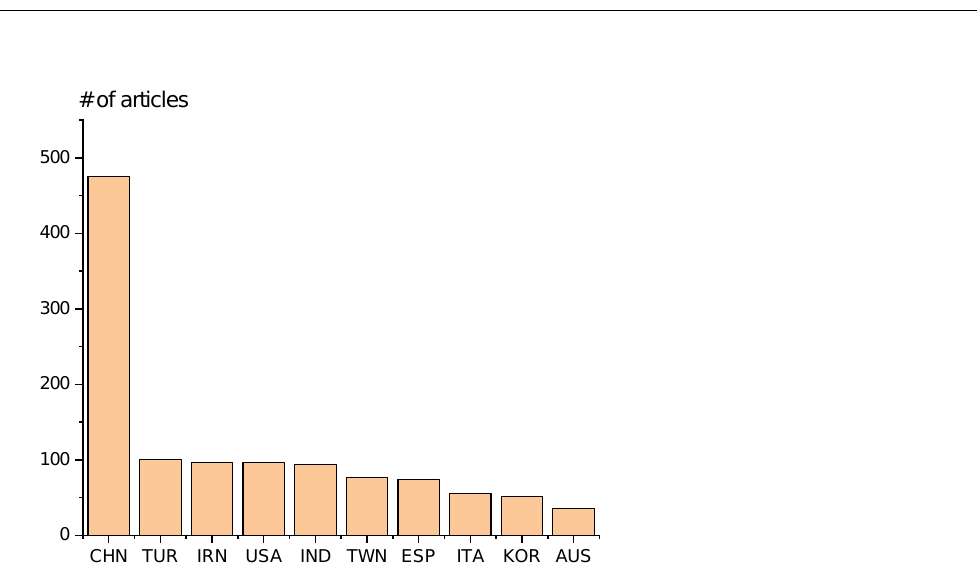
Figure 3. The key countries of AHP-related energy studies, based on the country of the corresponding author.